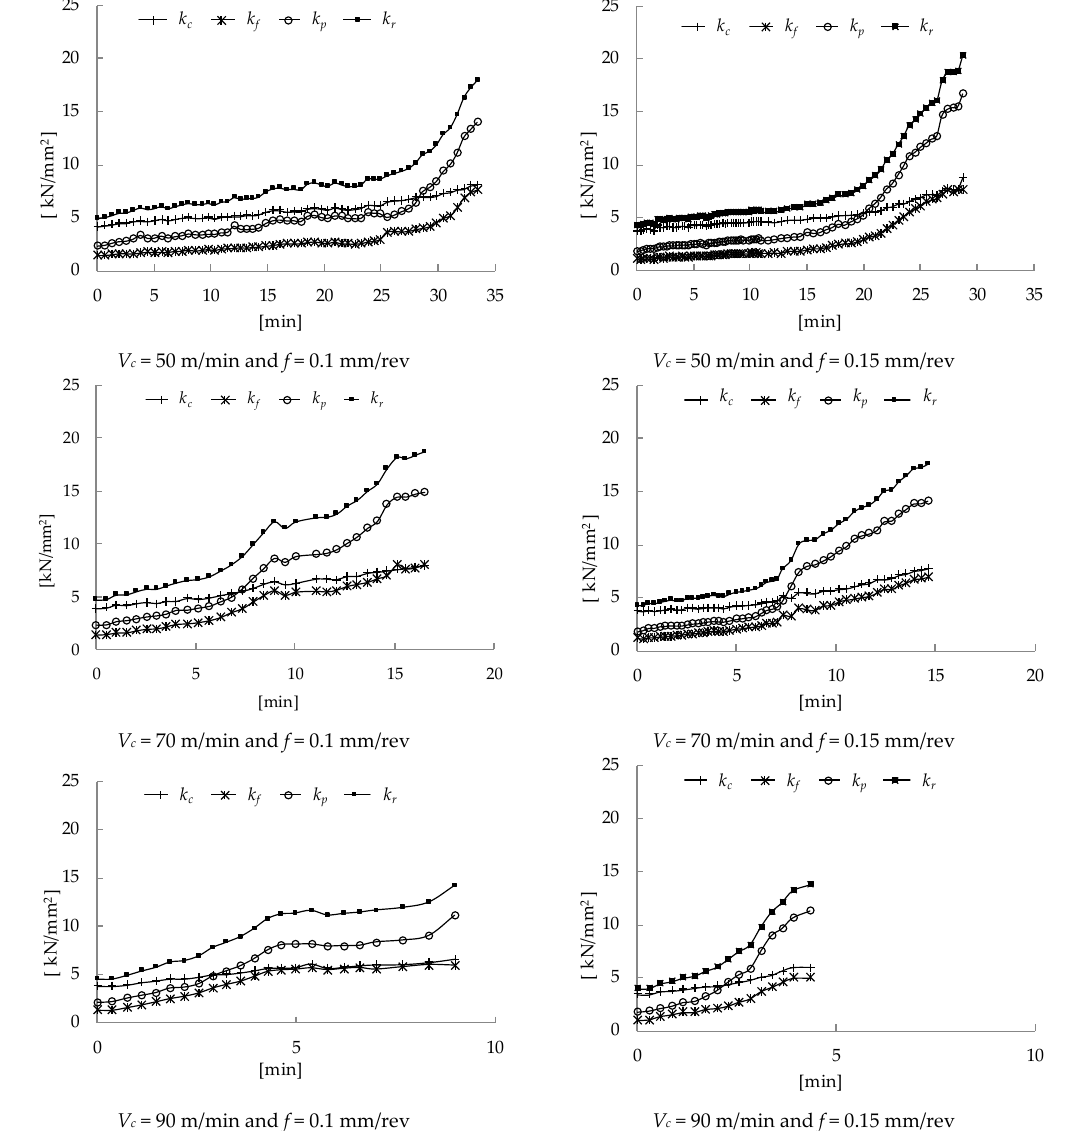
Figure 3. Evolution of the cutting forces for the carbide tool.